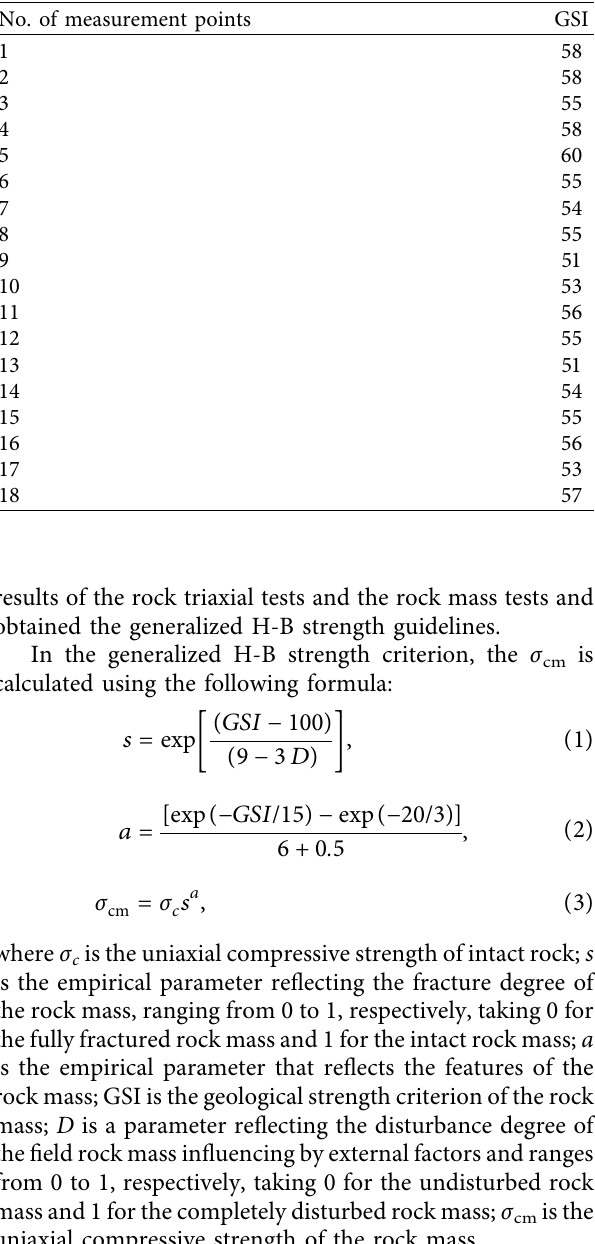
Table 5: GSI at different measurement locations.